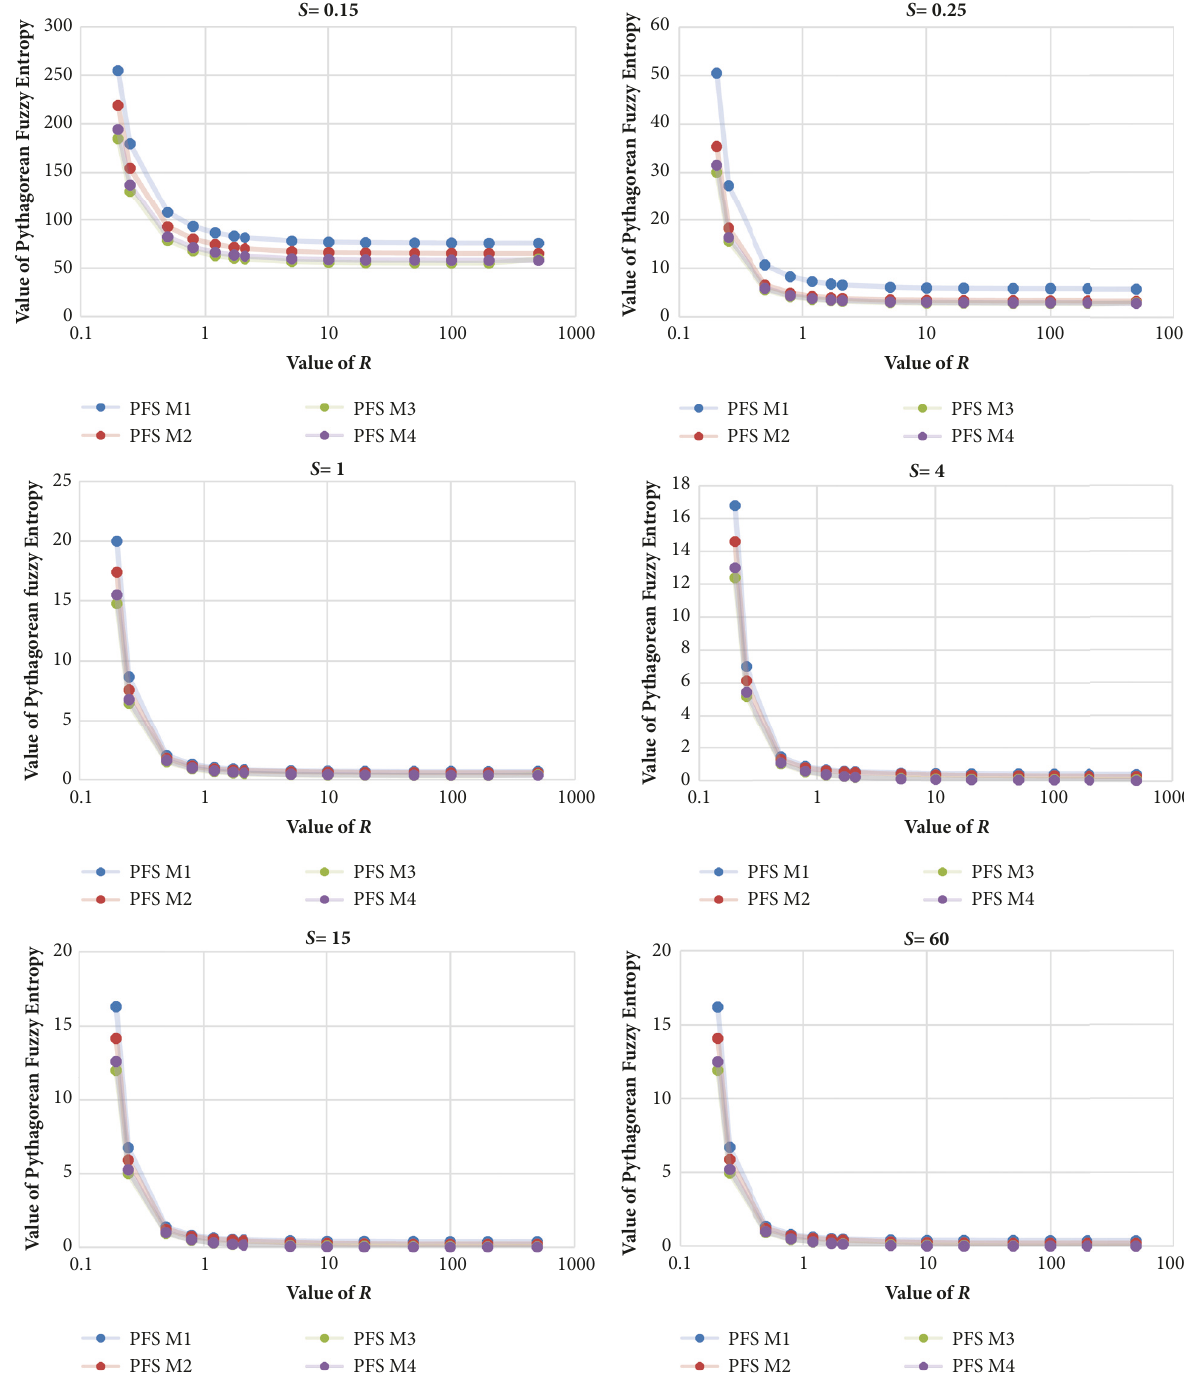
Figure 2: Monotonicity of the (𝑅,𝑆) -norm information